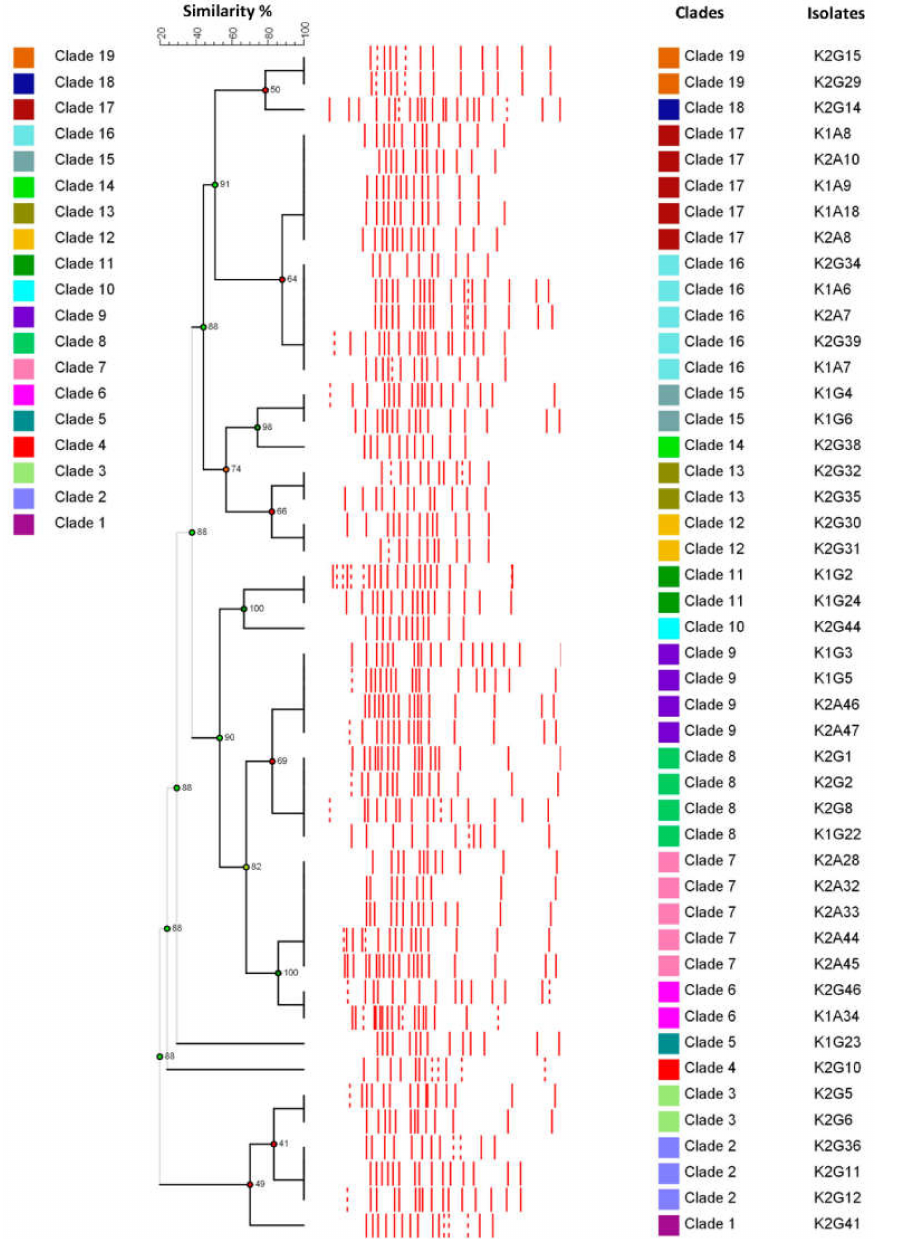
Figure 3. Dendrograms obtained from UPGMA analysis, using Dice’s coefficient, of the digitized patterns obtained from ERIC rep-PCR. The similarity threshold for biotypes discrimination was 70%. The cophenetic coefficient is represented by numbers and dots colored as red–orange–yellow–green, based on the branch